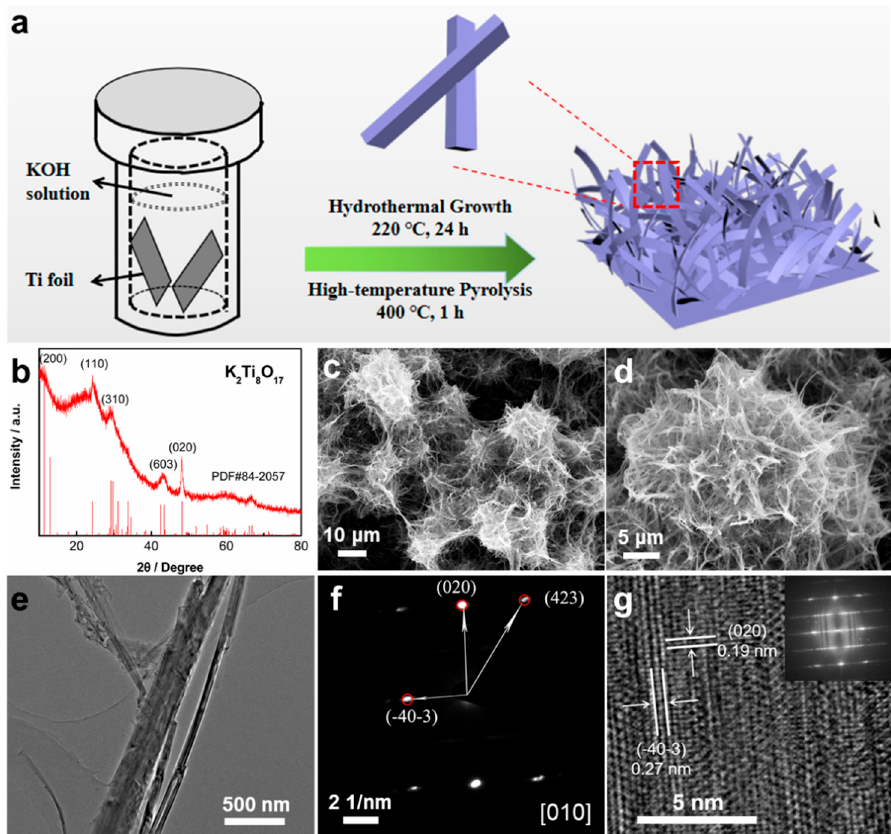
Figure 1. ( a ) Schematic of the preparation of K 2 Ti 8 O 17 electrode via a hydrothermal method combined with a post-pyrolysis process. ( b ) XRD patterns of the K 2 Ti 8 O 17 sample, ( c ) low- and ( d ) high- magnification SEM images of the TiO 2 NWAs film. ( e ) TEM image of the K 2 Ti 8 O 17 powder peeled from the titanium substrate. ( f ) Selected-area electron diffraction (SAED) pattern and ( g ) HRTEM image of the K 2 Ti 8 O 17 sample.